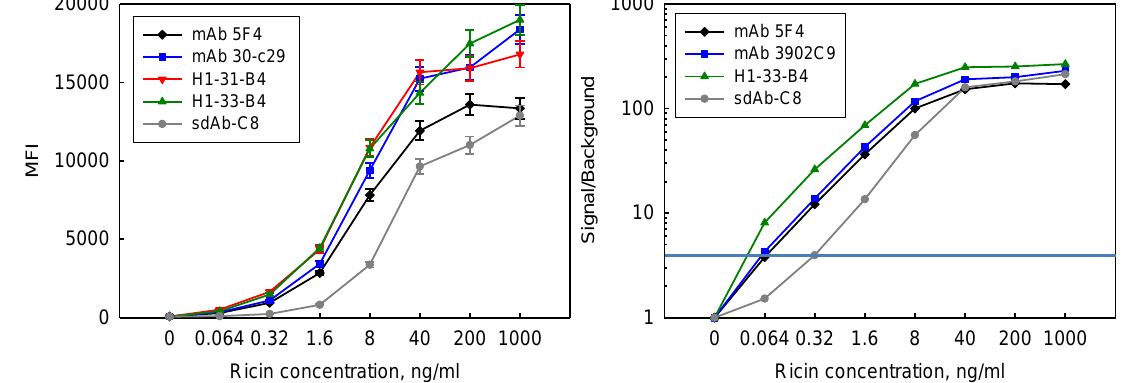
Figure 3. Fluid array assay for the detection of ricin using linked constructs, mAbs and an sdAb as capture reagents combined with a llama polyclonal anti-ricin reporter reagent. The signal. Error bars represent the variation between replicate experiments ( left ). The